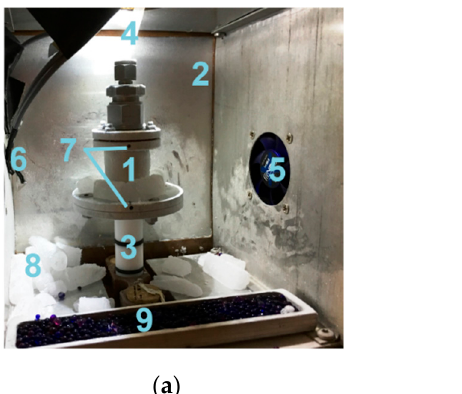
Table 1. Sample preparation parameters.